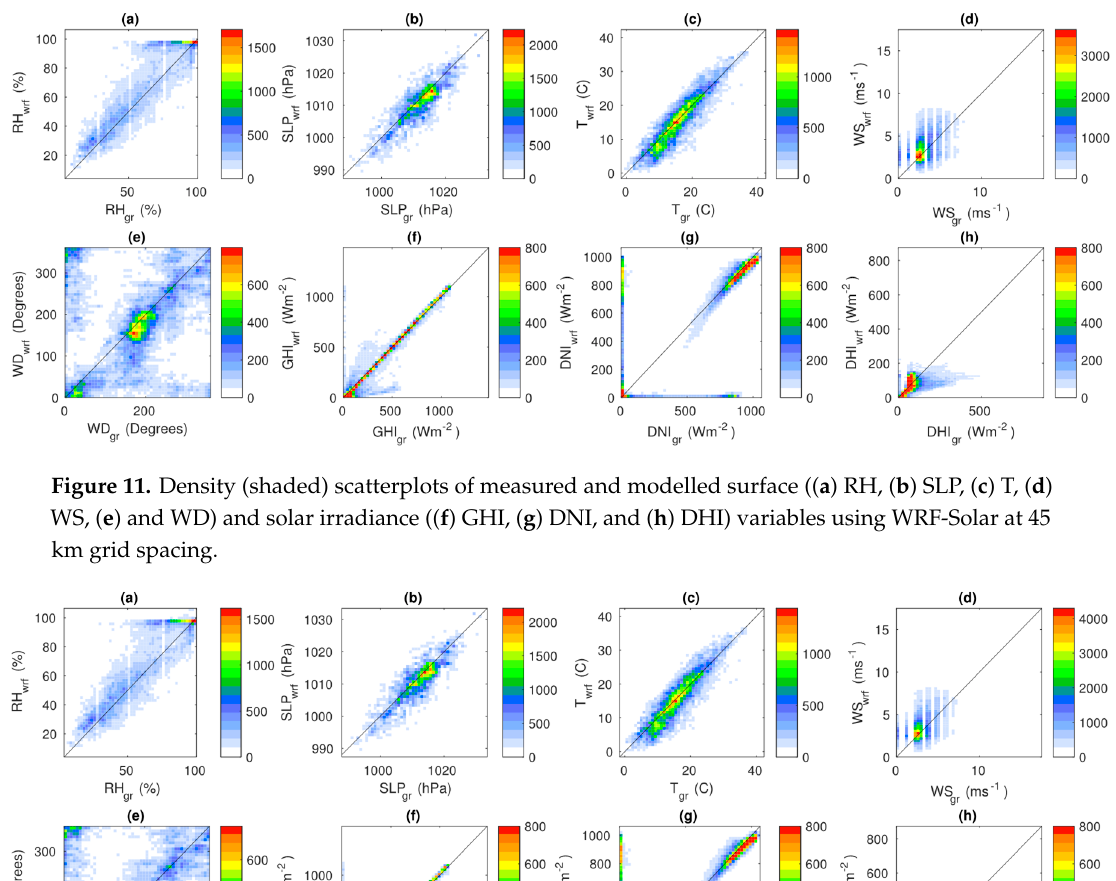
Table 4. Evaluation metrics for long-term simulations.